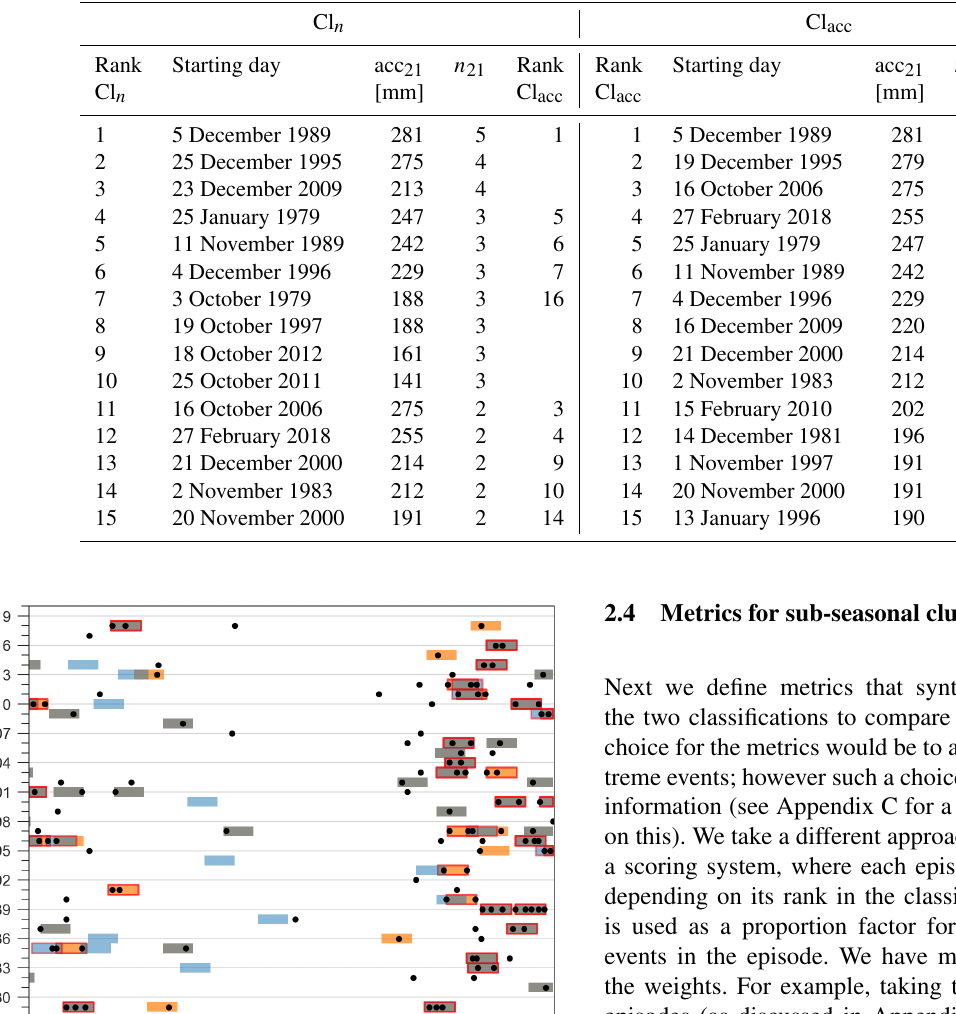
Table 2. First 15 episodes of the Cl n (left half) and Cl acc (right half) classifications for the catchment with HydroBASINS ID 2060654920. Episodes of Cl n (Cl acc ) are ranked according to their number of extreme events n 21 (their accumulation acc 21 ). The rightmost column of each panel indicates the corresponding rank of the episode in the other classification; if it is empty, the episode is not present in the other classification.